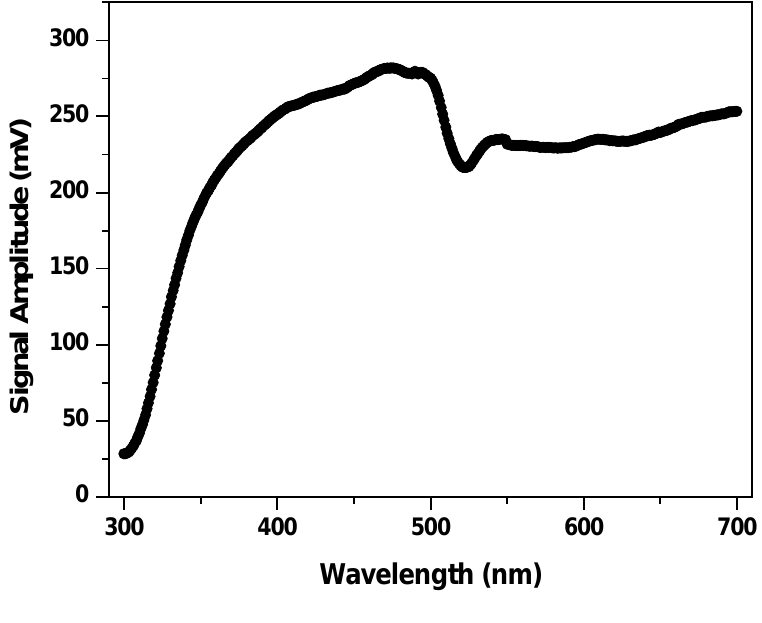
Figure 7. Reference signal amplitude obtained with the LDR. It can be seen that the curve is different from that obtained with the electret microphone, but the maximum signal intensity remains at 475 nm.